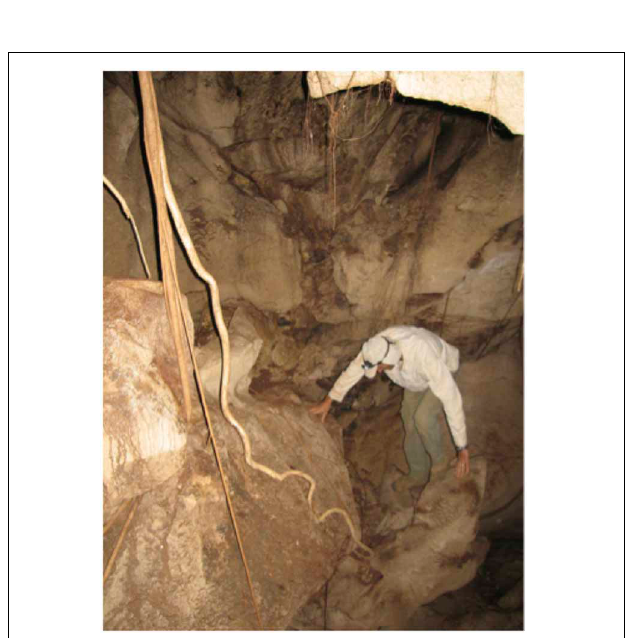
FIGURE 6 | Cave prospection (12m deep) for root studies in Lao PDR (Pierret,